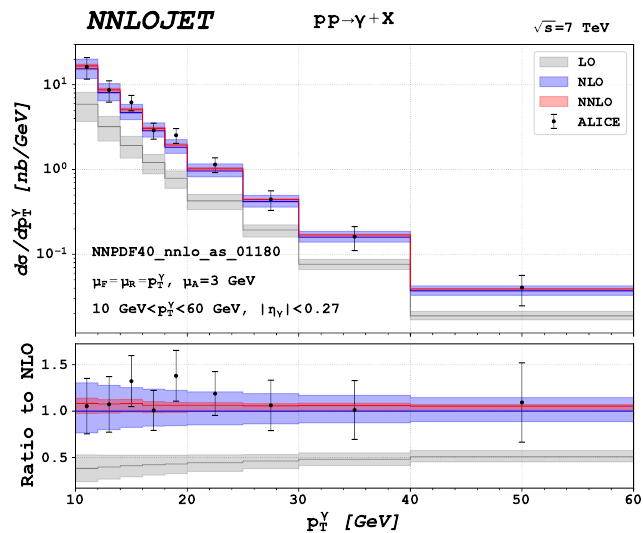
Figure 2. Predictions for the photon transverse momentum distribution at LO, NLO, and NNLO. The predictions are compared to data from the ALICE measurement